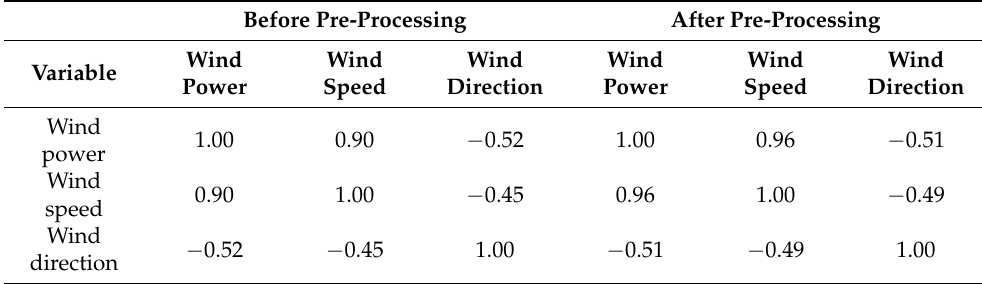
Before Pre-Processing After Pre-Processing